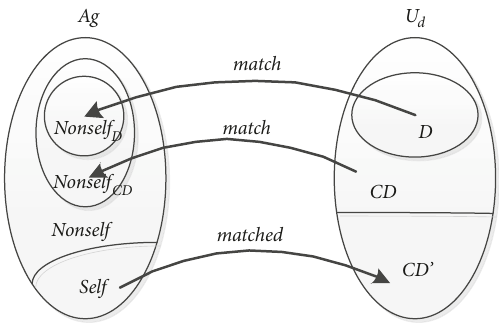
Figure 4: Relationships between